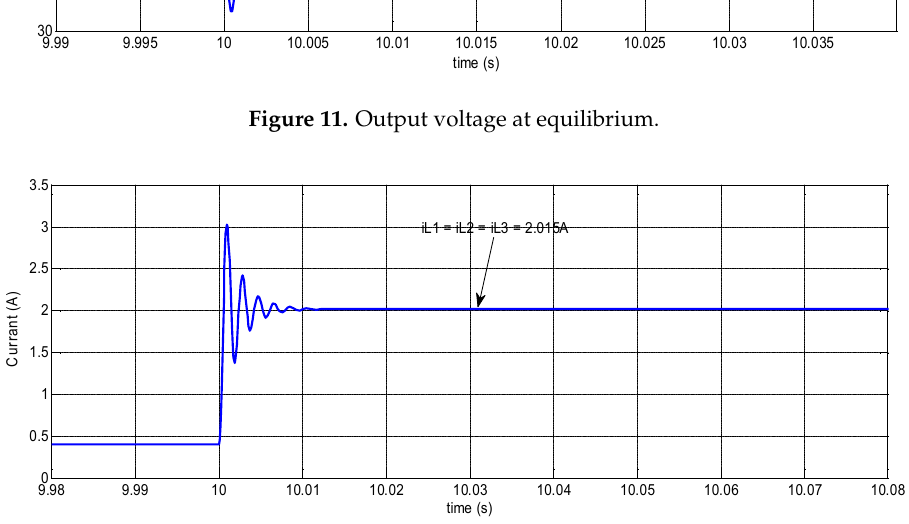
Figure 12. Output current at equilibrium.